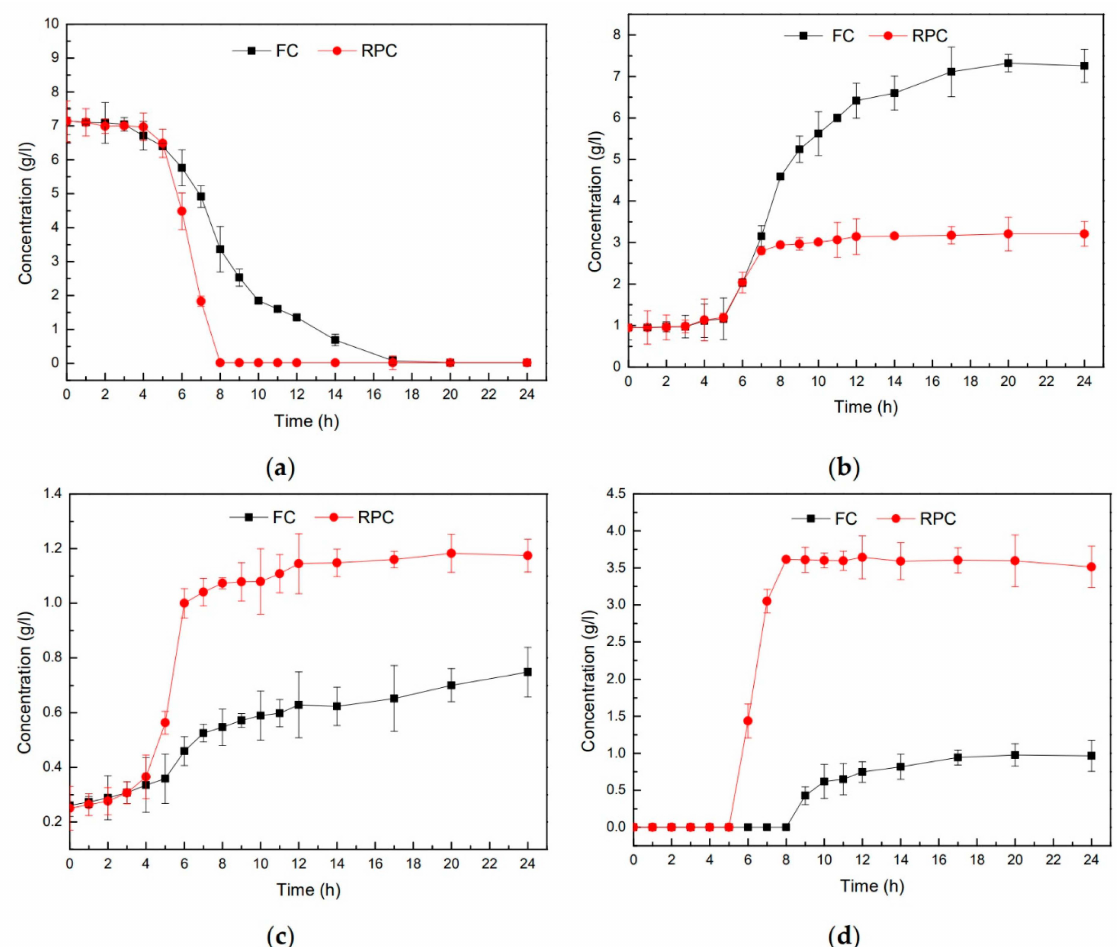
Figure 2. Metabolic production alterations of the strain E. faecalis LD33 cultured under FC and RPC. ( a ) Glucose, ( b ) lactate, ( c ) acetate, and ( d ) acetoin plus diacetyl, which all indicate the change of their concentration during the growth of 24 h. RPC and FC mean E. faecalis LD33 cultured under respiration-permissive and fermentation conditions,